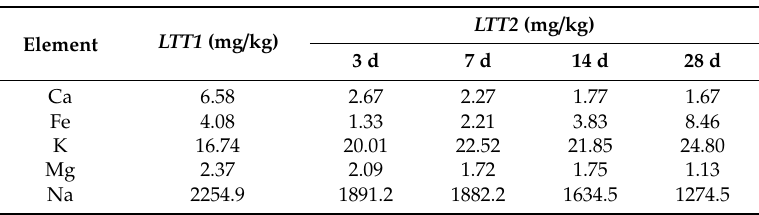
Table 7. Solubility of PB2 species not included in 2003 / 33 /